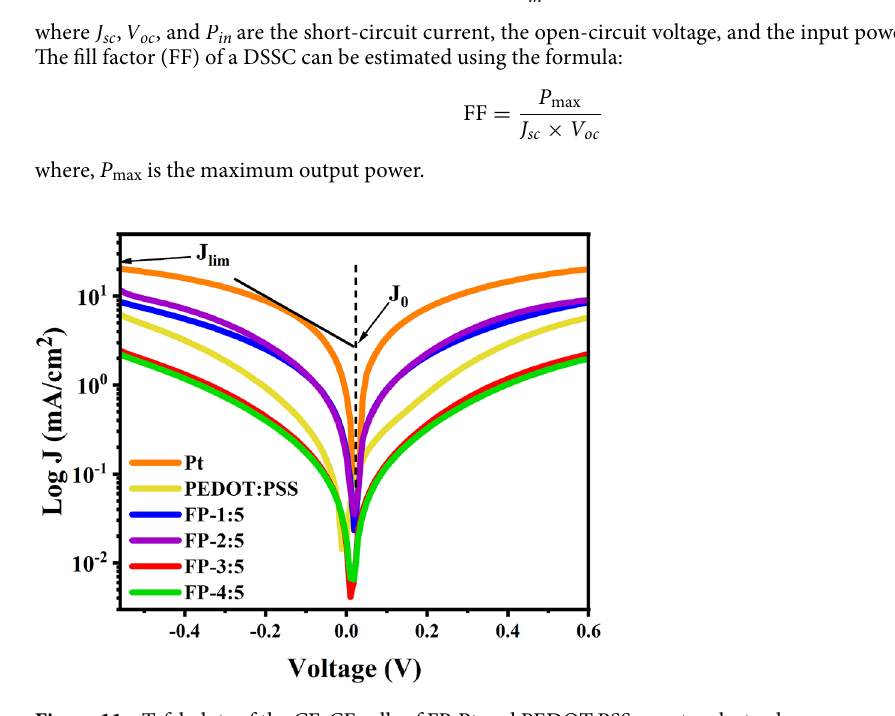
Figure 11. Tafel plots of the CE-CE cells of FP, Pt and PEDOT:PSS counter